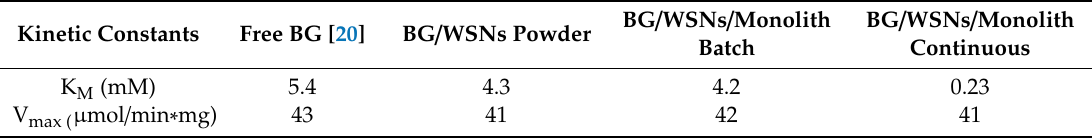
Table 1. Apparent kinetic parameters of di ff erent BG-based reaction